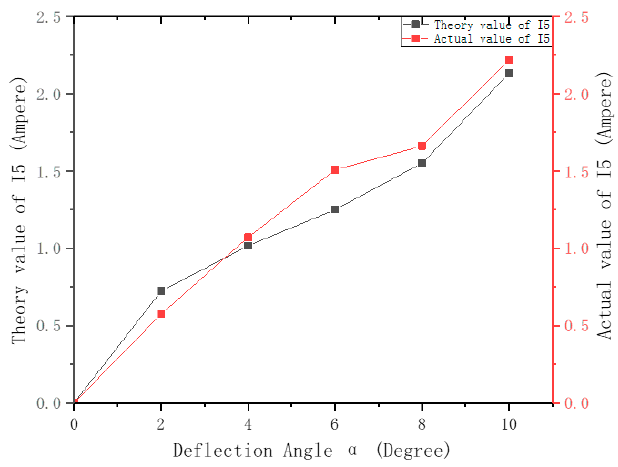
Figure 14. The actual input electric current of 𝑰⃗(𝑰 𝟏 𝑰 𝟐 𝑰 𝟑 𝑰 𝟒 𝑰 𝟓 ) and its theoretical value in different deflection angles 𝜶(𝑰⃗) . 𝑰 𝟏 is set as 2A, 𝑰 𝟐 and 𝑰 𝟑 is set as 1 A, 𝑰 𝟒 is set as 0 A.